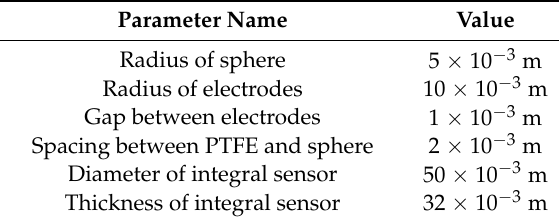
Table 1. Dimensions of the